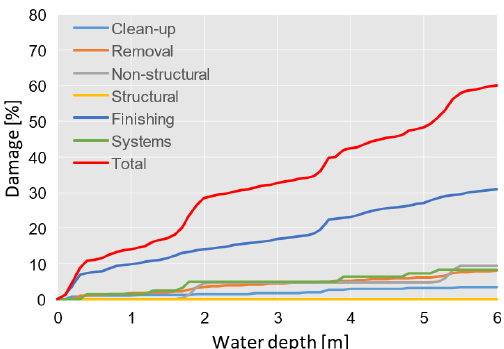
Figure 2. Examples of damage curves in relation to water depth produced by INSYDE for riverine floods in relation to a building with FA = 100m 2 , NF = 2, BT = 3, BS = 2, FL = 1, YY = 1990 and CS =